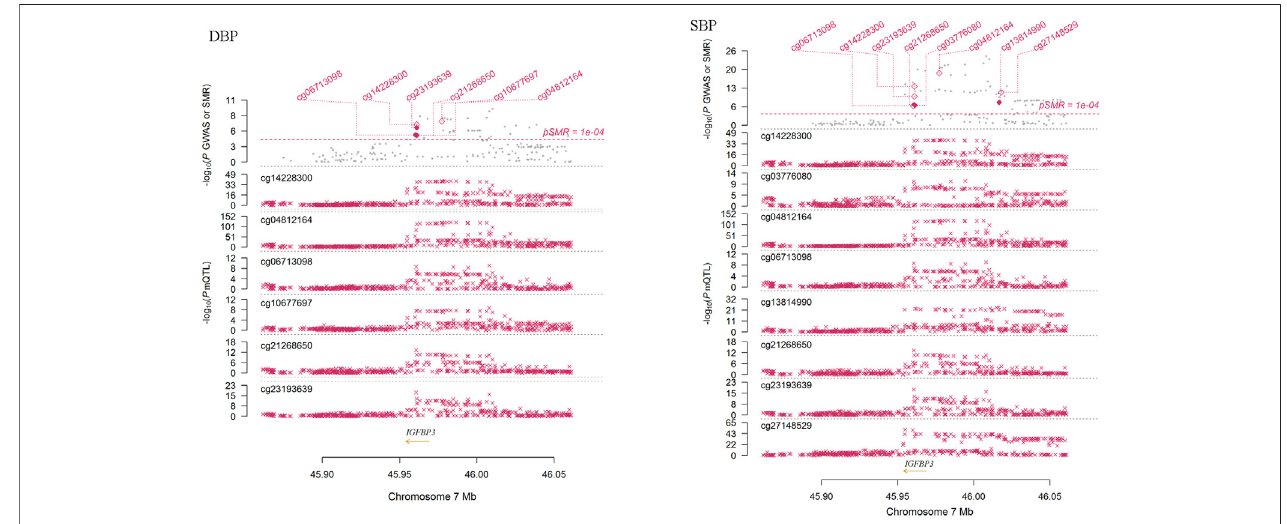
FIGURE 4 | The association between IGFBP3 methylation and DBP in Europeans. This fi gure presented the result of SMR analysis. The x -axis represented the genomic position (GRCh37.p13). Along the y -axis direction the fi gure consisted of two parts. The lower part showed the information of mQTL for six methylation sites. The y -axis represents -log10 ( P mQTL). In this part, we can see that IGFBP3 SNPs were strongly associated with IGFBP3 methylation levels. The upper part shows the resultsofGWASandSMRanalysis.The y -axisrepresents − log 10 ( p valueofGWASorSMR).Inthispart,wefoundthat IGFBP3 SNPswerestronglyassociatedwith DBP according to the GWAS (grey dots) and IGFBP3 methylation levels were associated with DBP (diamonds).